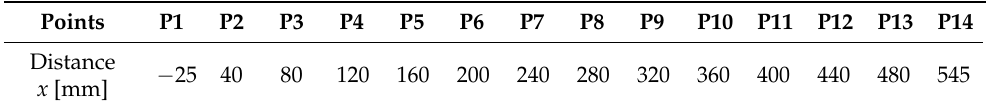
Table 3. Coordinates of measured points using a profilometer.